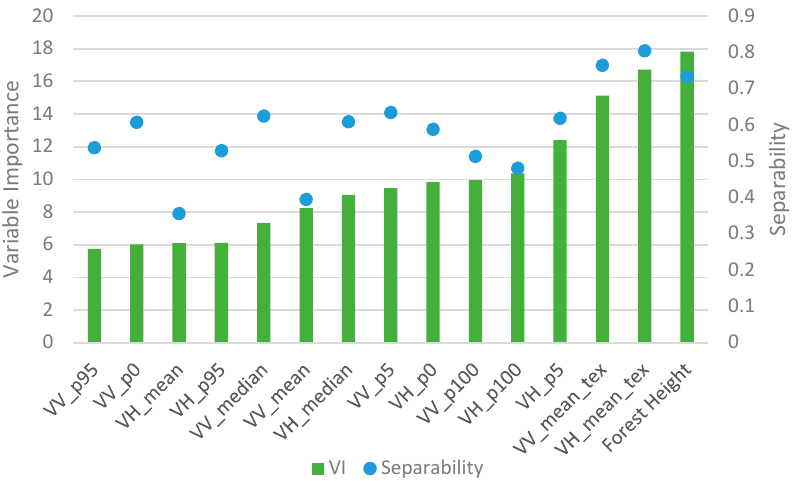
and the actual importance of that feature in the trained model (VI).